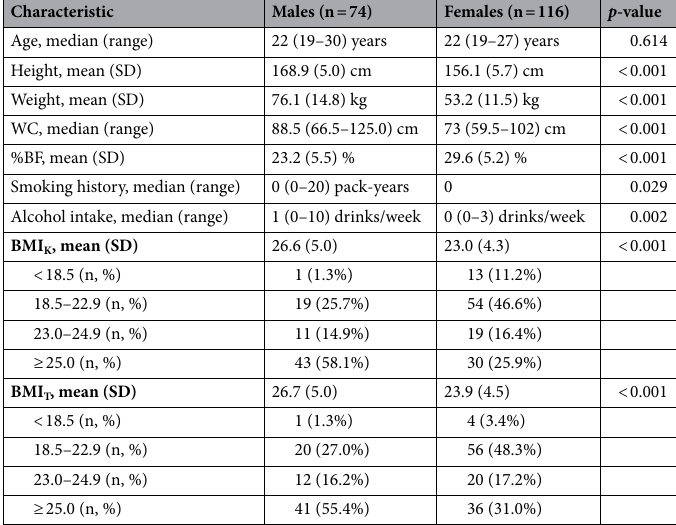
Table 1. Demographic and anthropometric characteristics of participants. %BF body fat percentage, BMI T BMI calculated using the proposed modified (Trefethen) formula, BMI K BMI calculated using the Quetelet index popularized by keys, WC waist